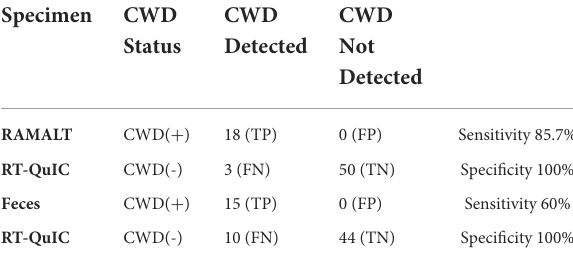
TABLE 1B Sensitivity and Specificity of feces for PrP Sc detection with RT-QuIC in white-tailed